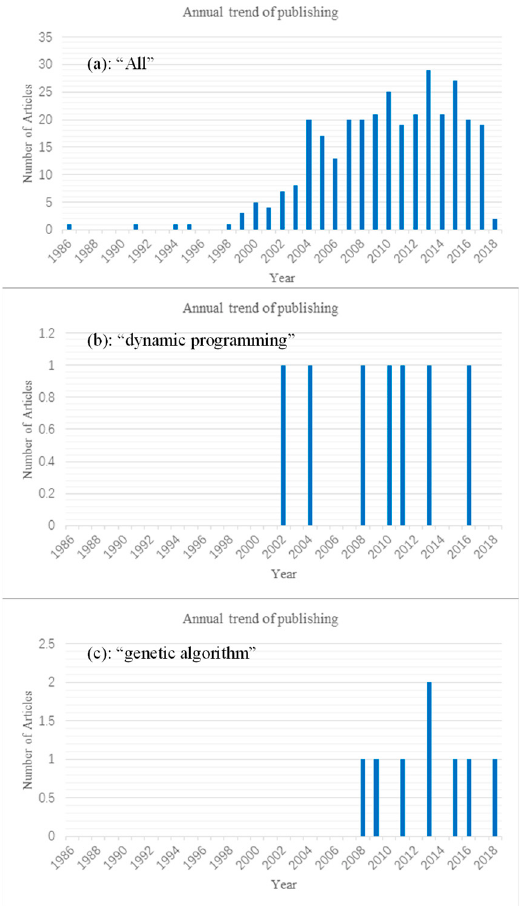
Figure 2. Yearly publications on WRDSs in the field of water sciences and the contribution rate of these common algorithm methods based on the China Knowledge Resource Integrated Database (CNKI) (www.cnki.net). ( a ) “All” is based on the search terms “Water resource dispatching” + “algorithm” in the CNKI. ( b ) “Dynamic programming” is based on the search terms “Water resource dispatching” + “dynamic programming” in the CNKI. ( c ) The “genetic algorithm” is based on the search terms “Water resource dispatching” + “genetic algorithm” in the CNKI.